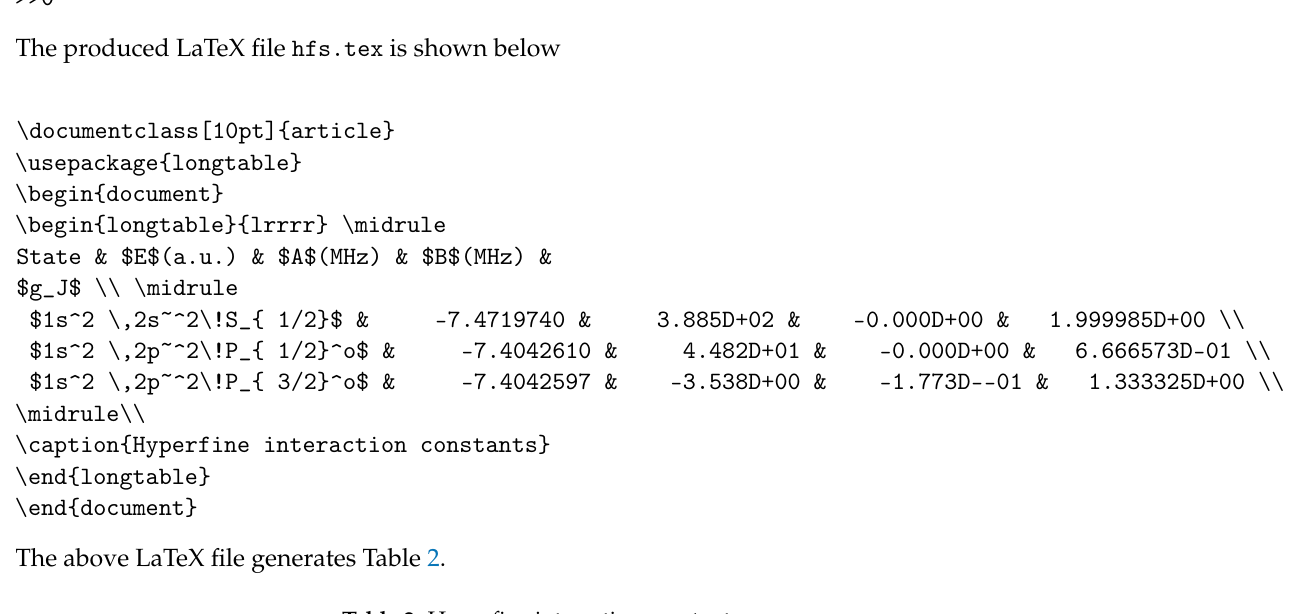
Table 2. Hyperfine interaction